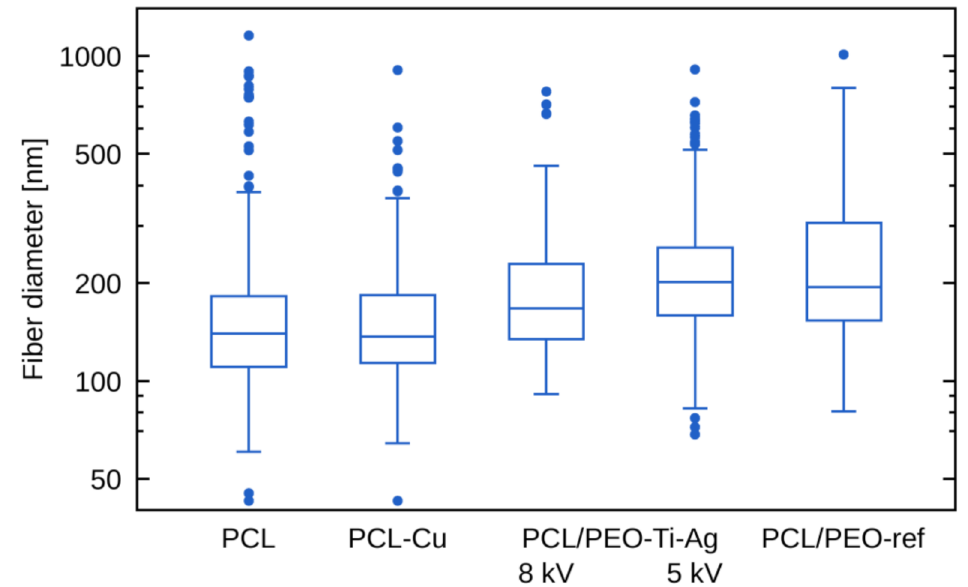
Figure 5. The fiber diameters for different samples evaluated from the SEM image analysis.